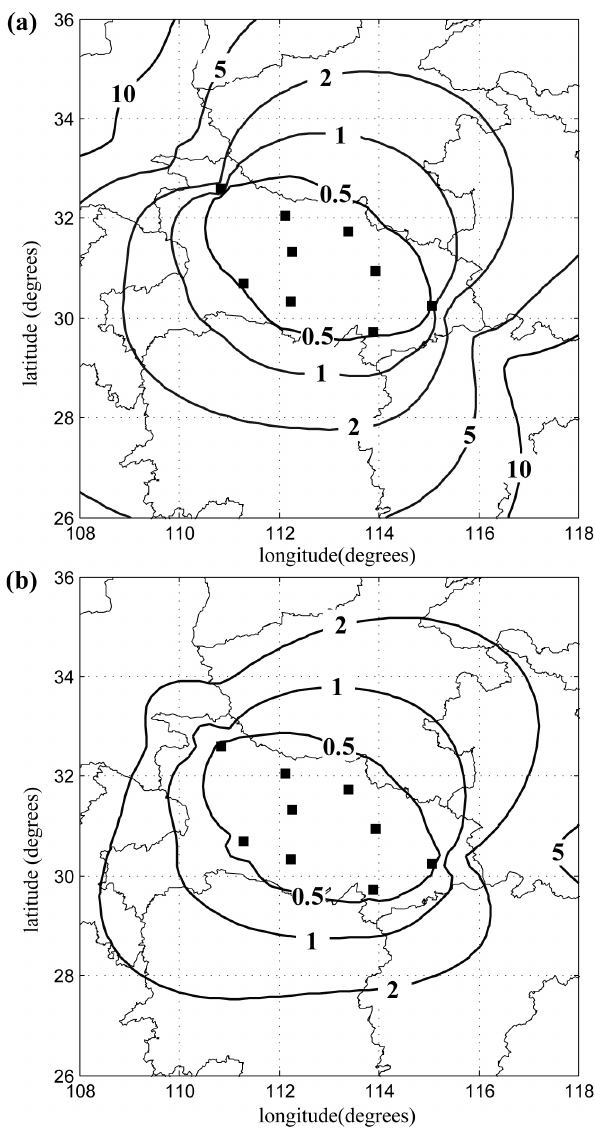
Fig. 11. Spatial distribution of the lightning source location error (RMSE) given by Eq. (35), (in kilometer): (a) only TOA measure- ments are used, (b) both TOA and AOA measurements are